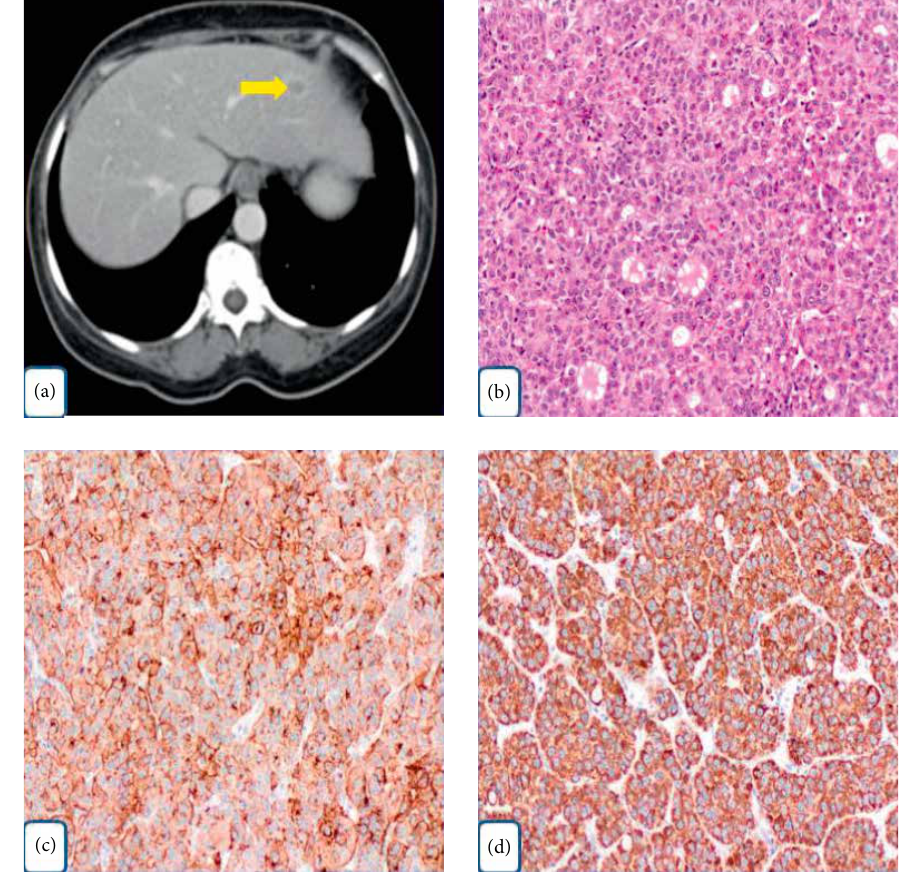
Figure 2: (a) CT scan of abdomen with contrast illustrates solitary hypodense liver lesion in left lobe (yellow arrow). (b) Hepatocellular carcinoma showing pseudoglandular (acinar) pattern (H&E; 100x). (c) Tumor cells expressing positive staining for Glypican-3 (100x). (d) Tumor cells expressing strong positive staining for HepPar-1